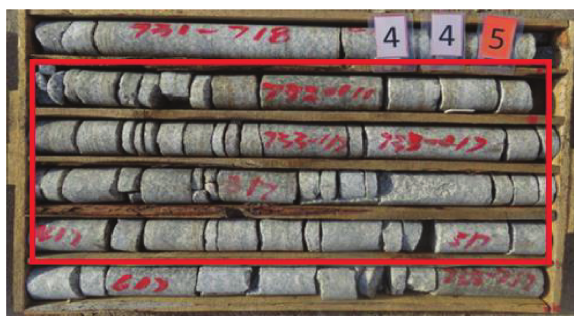
Figure 4: Rock core disking phenomenon in an exploration hole with depth 2017m.